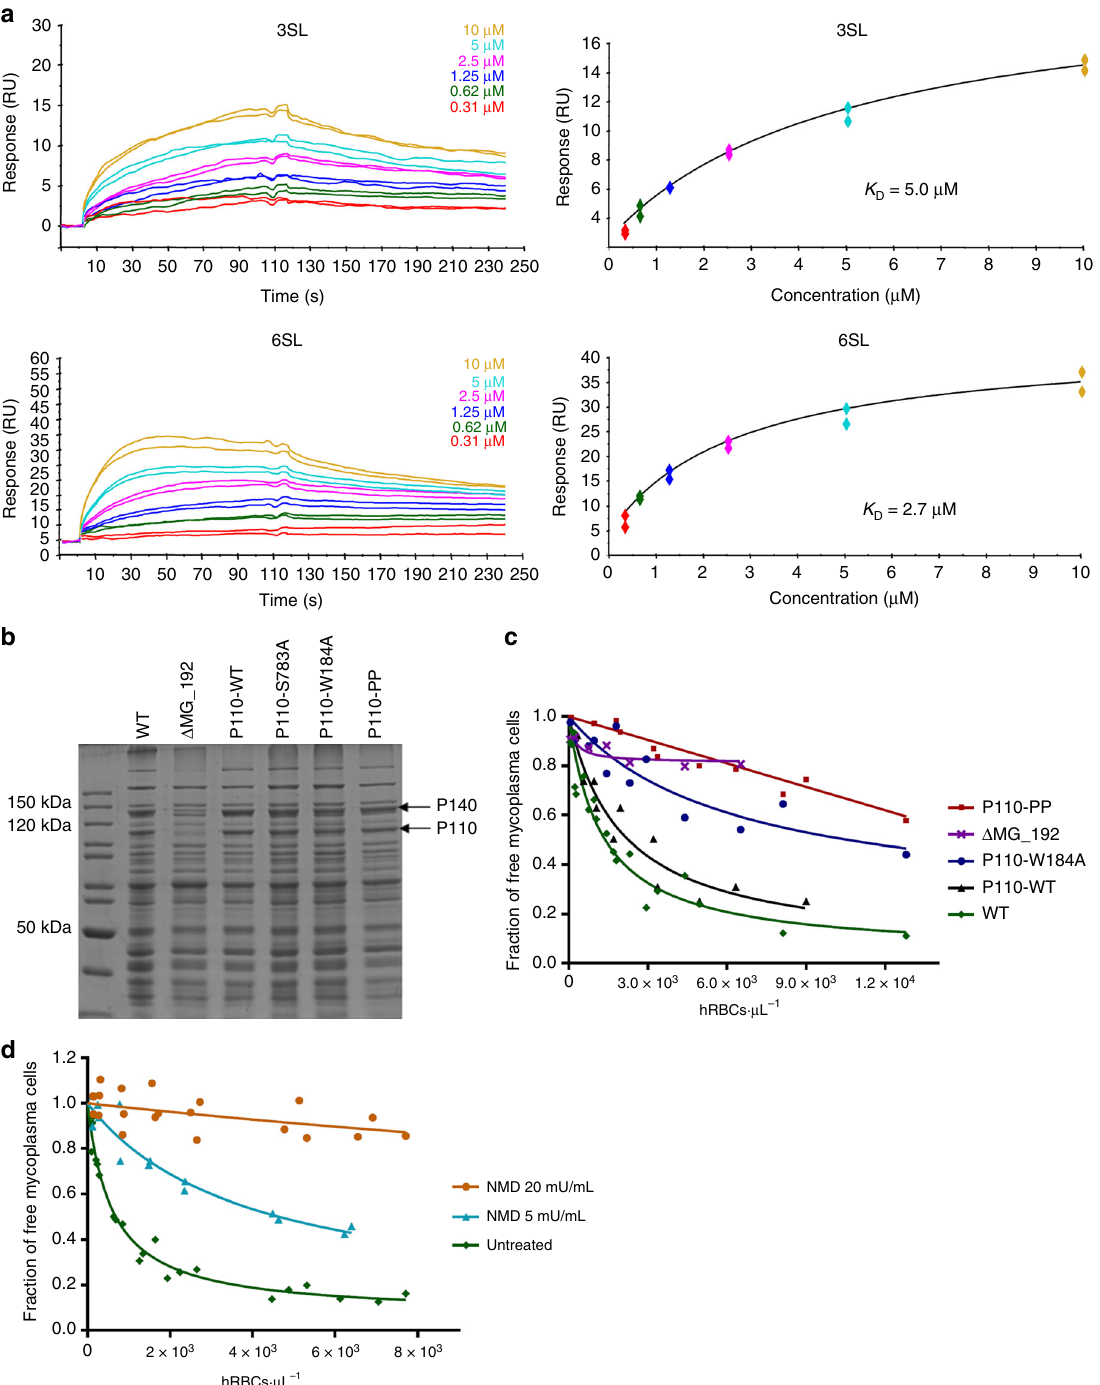
Fig. 4 Af fi nity of oligosaccharides by SPR. Characterization of M. genitalium P110 variants. a SPR sensorgrams showing the binding of the erP110 β -propeller N-domain to immobilized 3SL and 6SL (upper and lower left panels, respectively). Data fi tting of duplicates assuming a Langmuir 1:1 af fi nity model depicting the K D calculated in steady state for 3SL and 6SL (upper and lower right panels, respectively). b SDS – PAGE of whole cell lysates from WT and different P110 mutant strains. c HA assays determined by FACS analysis. Graphic depicts inverse Langmuir plots obtained with a fi xed amount of mycoplasma cells and increasing amounts of hRBCs. Plots were generated using data from, at least two biological repeats for each strain. d HA assays of the WT strain using neuraminidase-treated